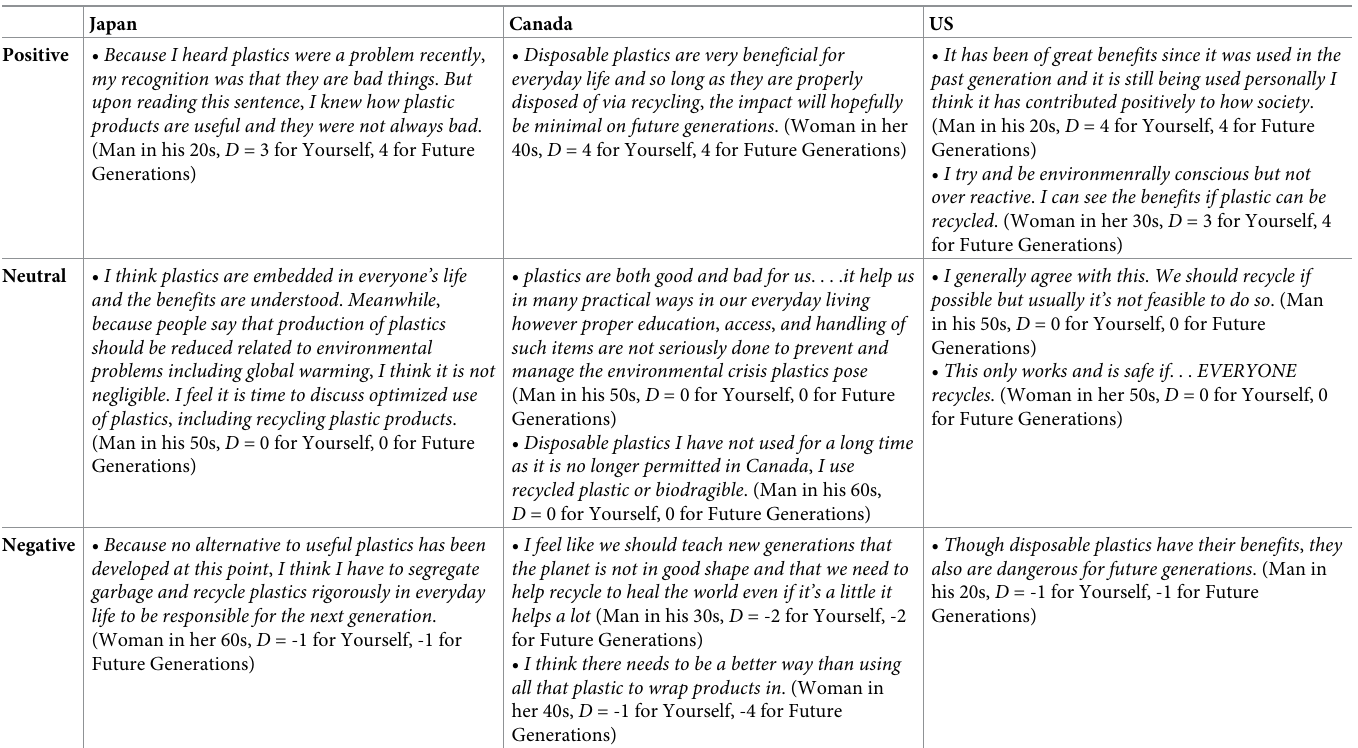
Table 8. Characteristic responses for